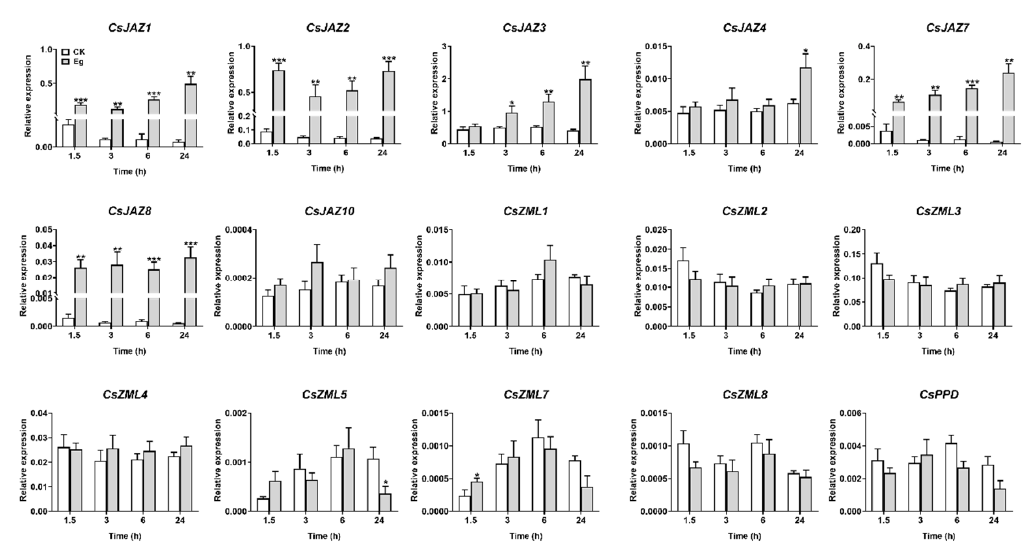
Figure 7. Expression profile of CsTIFY genes elicited by the infestation of E. obliqua . Data are shown by the mean + SE, asterisks indicate significant di ff erence between treatment and control (Student’s t -test, * p < 0.05, ** p < 0.01, *** p < 0.001, n = 6).